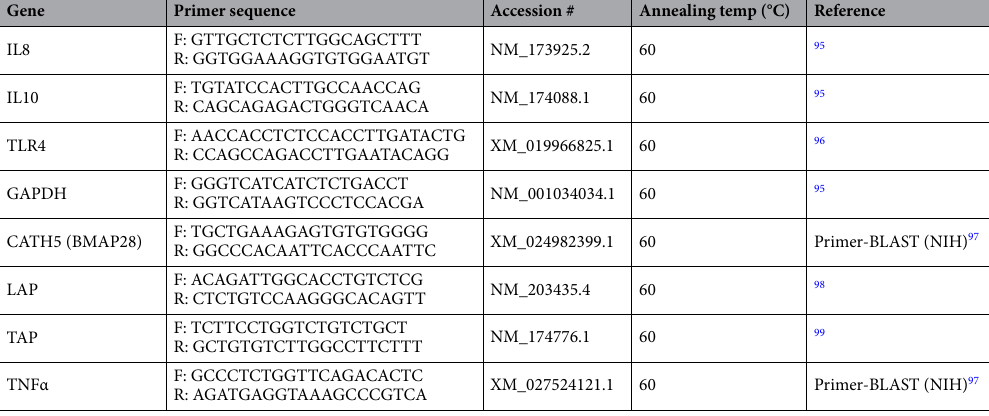
Gut microbiota profiling using amplicon sequencing. Mucosal tissue and digesta samples were col- lected from the ileum and rectum of uninfected and E. coli O157: H7 infected calves (14 d post-challenge). Mucosal tissue samples were rinsed with sterile PBS (pH 7.0) to remove the digesta and immediately snap- frozen. Samples of ileum and rectums were physically disrupted by a bead-beating step (FastPrep-24, MP Bio- medicals). Total DNA was extracted from mucosal tissue and digesta samples of each gut region (220 mg wet weight) (QIAMP DNA stool kit, Qiagen), quantified (Qubit fluorometer, Qiagen) and stored (−80 °C) until fur- ther processing. The V3-V4 hypervariable regions of the 16S rRNA gene were amplified from the extracted DNA